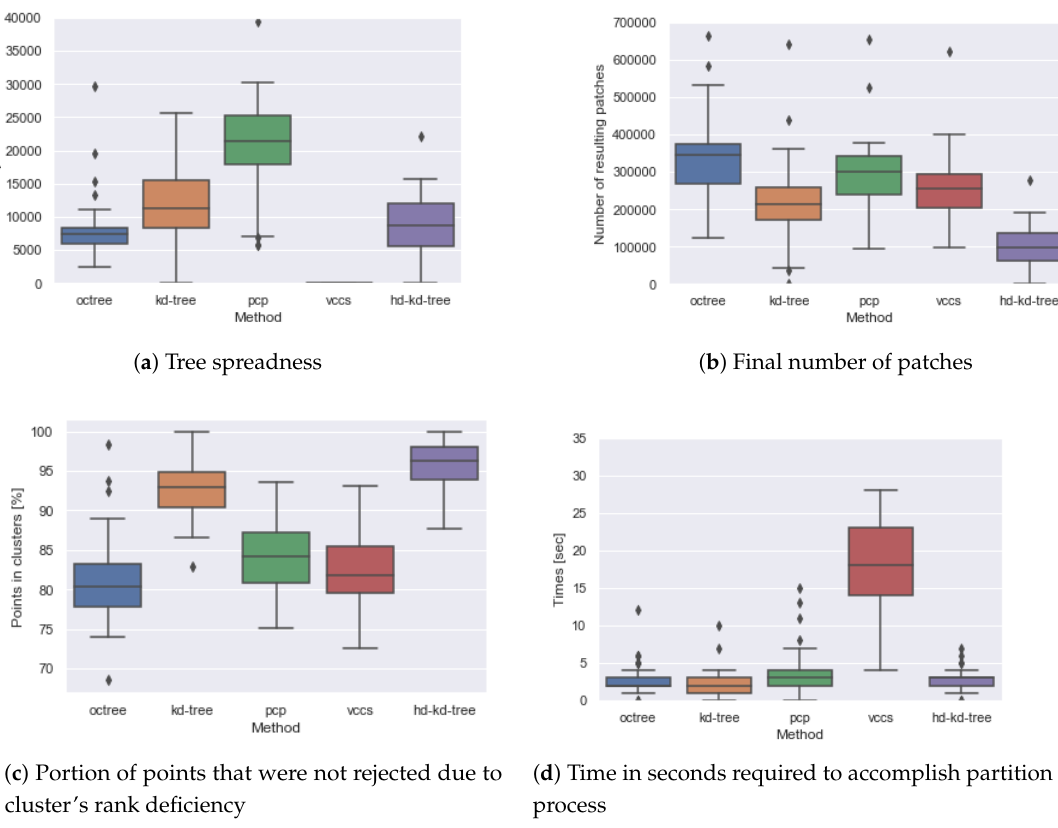
Figure 7. Juxtaposition of tree spreadness (the number of all nodes in tree), final number of clusters, portion of preserved points, and times for benchmark space partition algorithms and the proposed